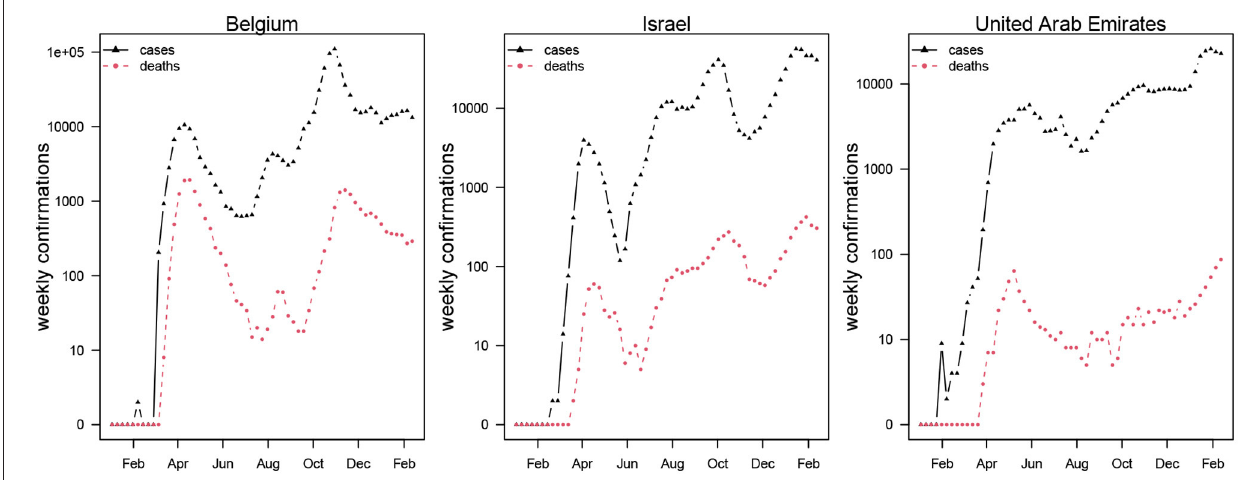
FIGURE 1 | Weekly confirmed cases (in black triangles) and deaths (in red circles) of COVID-19 in Belgium, Israel, and the United Arab Emirates.